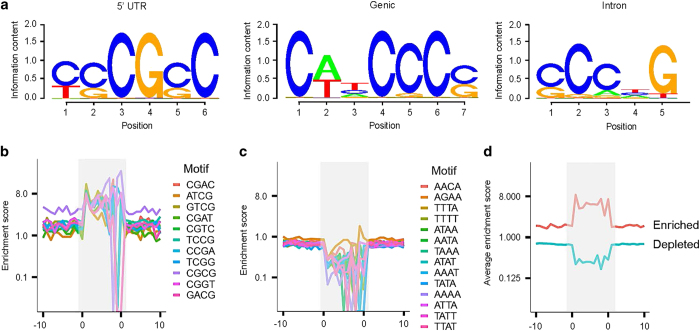
Sequence-binding characteristics of PARP1-bound RNAs. (a) Logo plots of some of the motifs found in the various PARP1-binding regions as determined by cERMIT. (b) Enriched 4-mer motifs found within percentile regions of the PARP1-binding site (gray) along with their enrichment scores in the flanking upstream and downstream regions. (c) Depleted 4-mer motifs within the PARP1-binding site (gray) along with their enrichment scores in the flanking upstream and downstream regions. The enrichment scores for b, c are determined by the log2 odds score of the frequency of the motif in the region versus the frequency of the motif in the genome. (d) Average enrichment score for enriched and depleted motifs from (b, c), respectively.